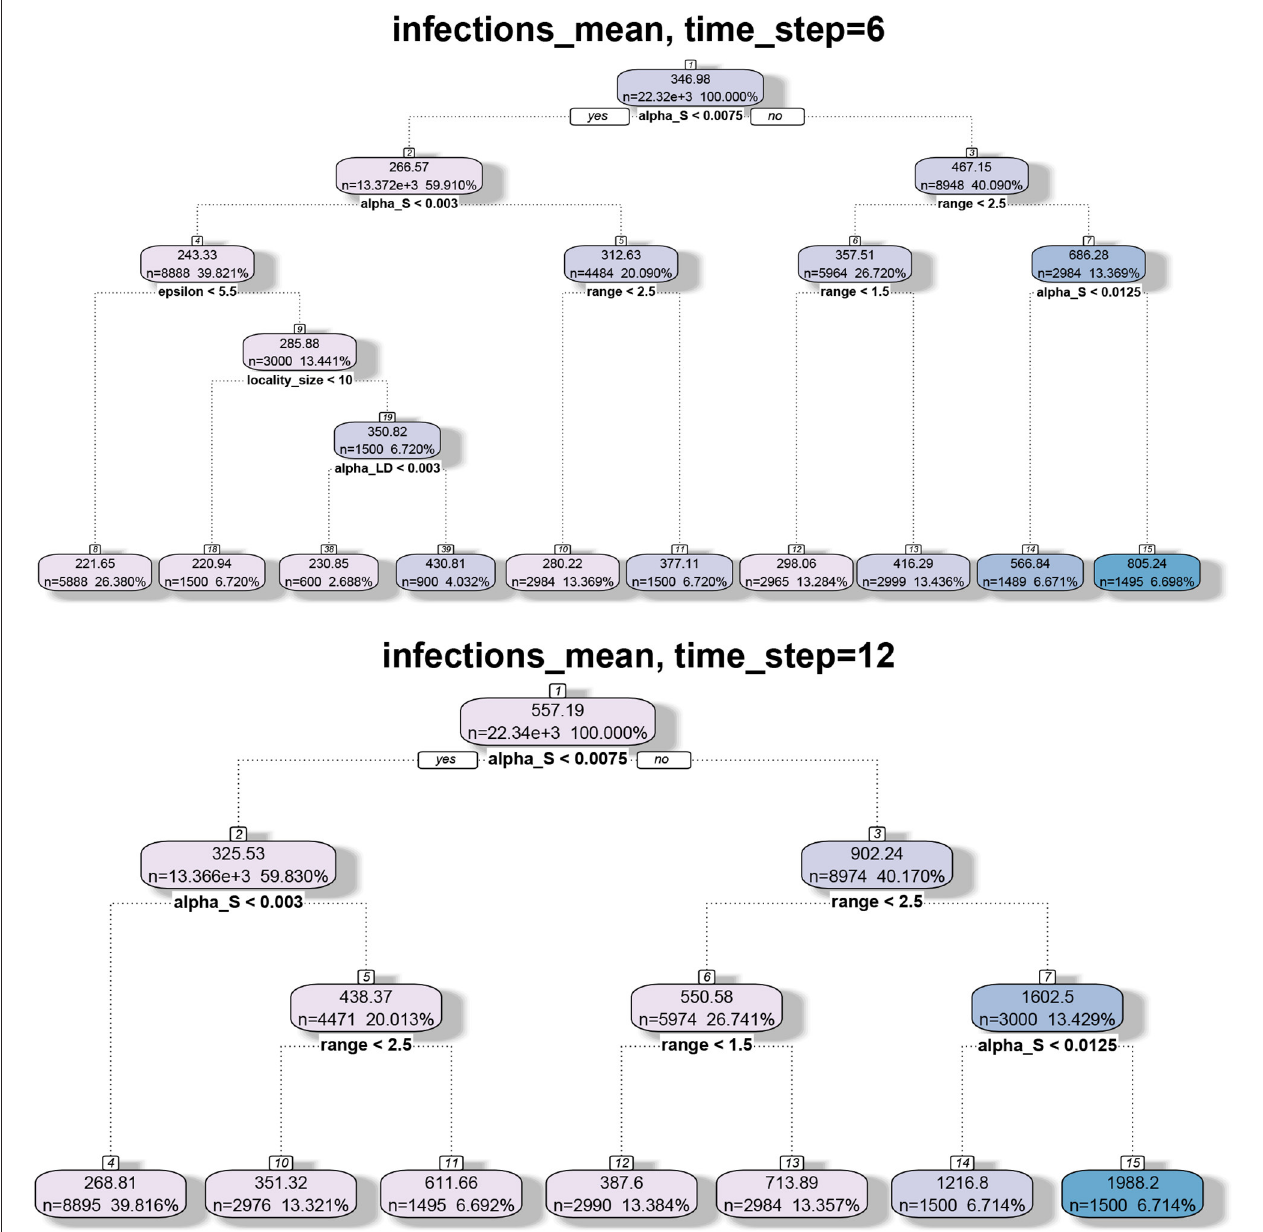
FIGURE 7 | Regression tree analysis of simulation results where the independent variables are the MPSN parameters and pathway parameters of the SPREAD model and the observed variable is the mean number of infections at different time steps T .